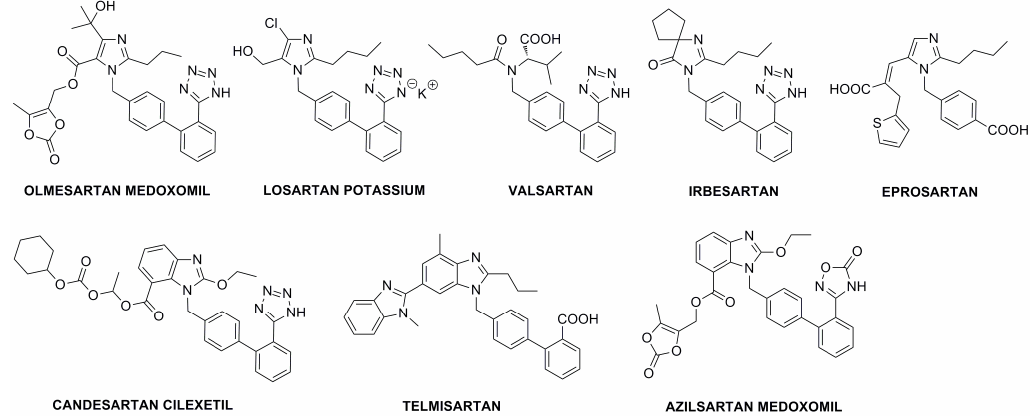
Figure 1. Structures of angiotensin II receptor blockers used as APIs in the treatment of hypertension.